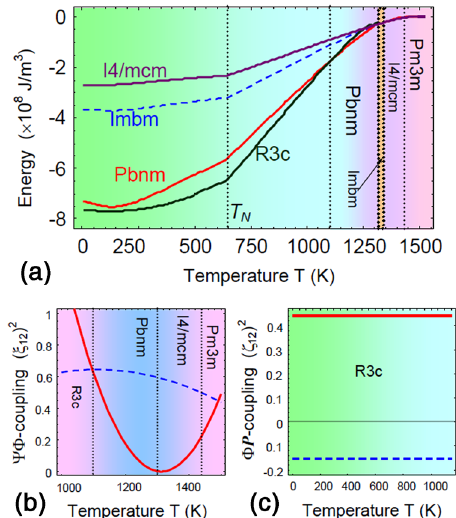
(cid:5) (cid:6) 2 and the blue dashed 12 (cid:6) 2 and the blue dashed